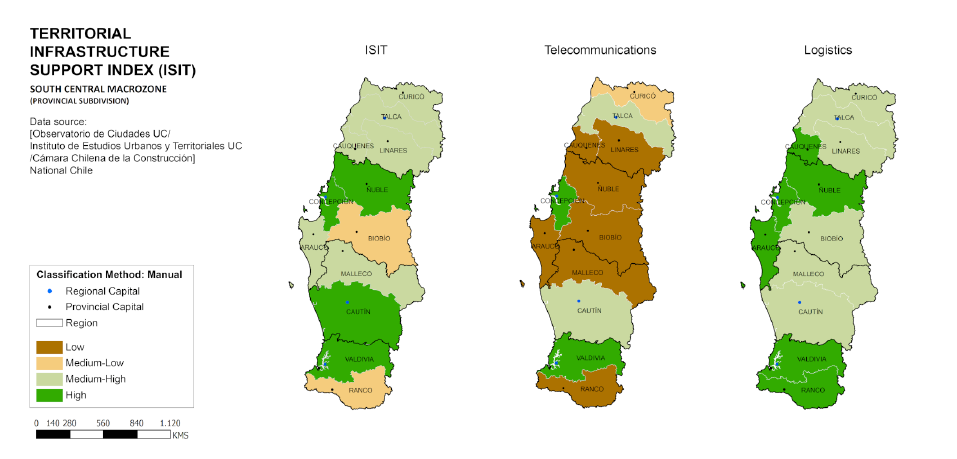
Figure 4: ISIT of provinces of the central-south